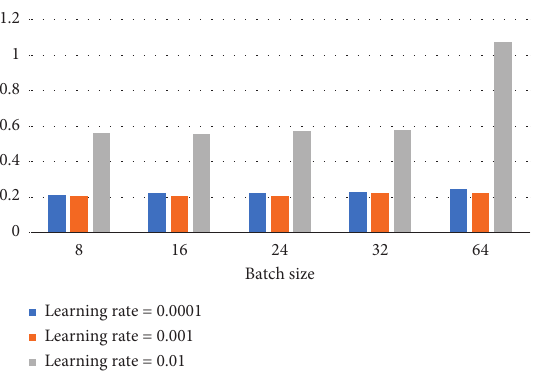
Figure 8: The RMSE results of determining batch size and learning rate.